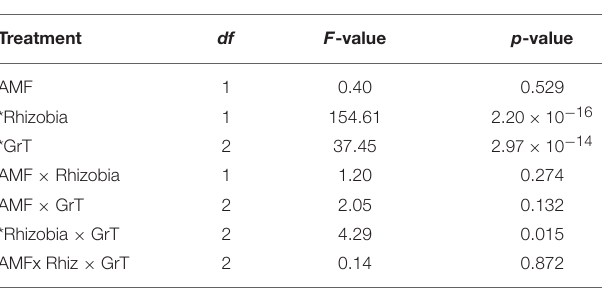
TABLE 4 | Three-way ANOVA results of root:shoot fresh mass of M. truncatula 28 dpi after microbial inoculation and gravitational treatments (GrT). Three-way ANOVA results of root:shoot fresh mass